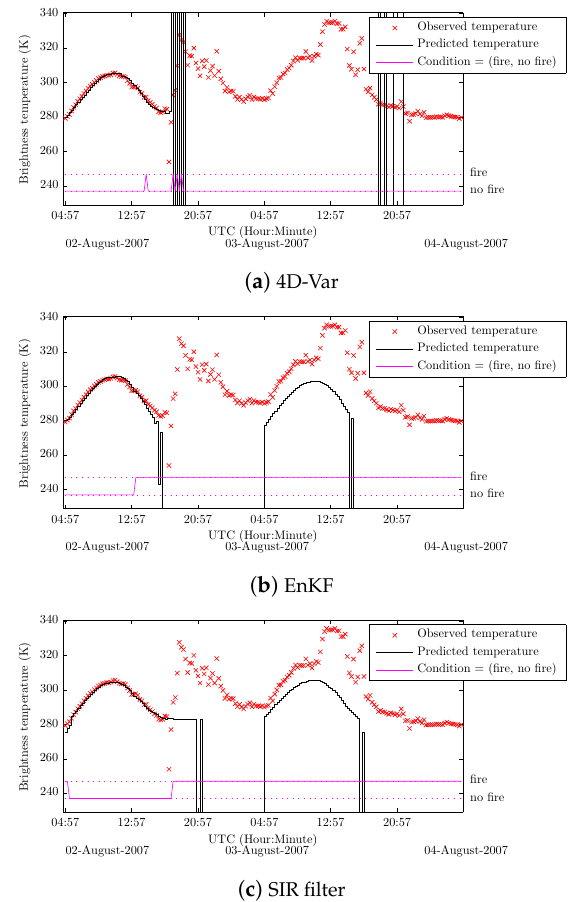
Figure 8. Example of a detection of a fire extending over two DTCs. Level 1.5 pixel at ( 995,896 ) (Line, Column) with pixel center at ( 25.2224 ◦ S,31.3448 ◦ E ) . Detection at 10 − 3.5